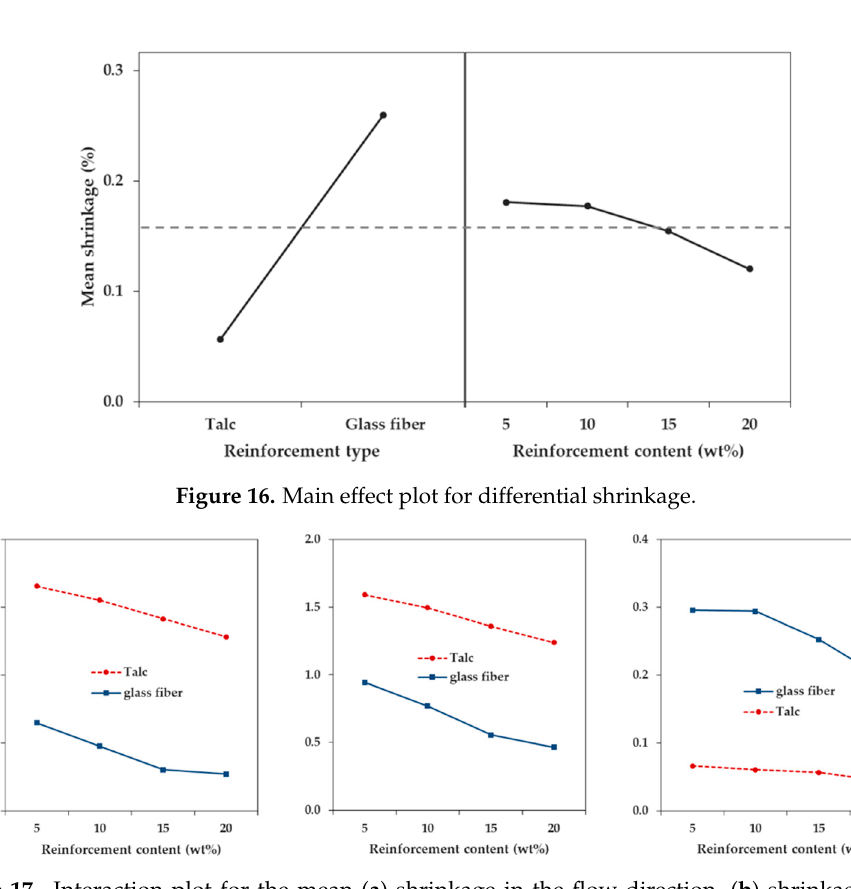
Figure 17. Interaction plot for the mean ( a ) shrinkage in the flow direction, ( b ) shrinkage in the transverse direction, and ( c ) differential